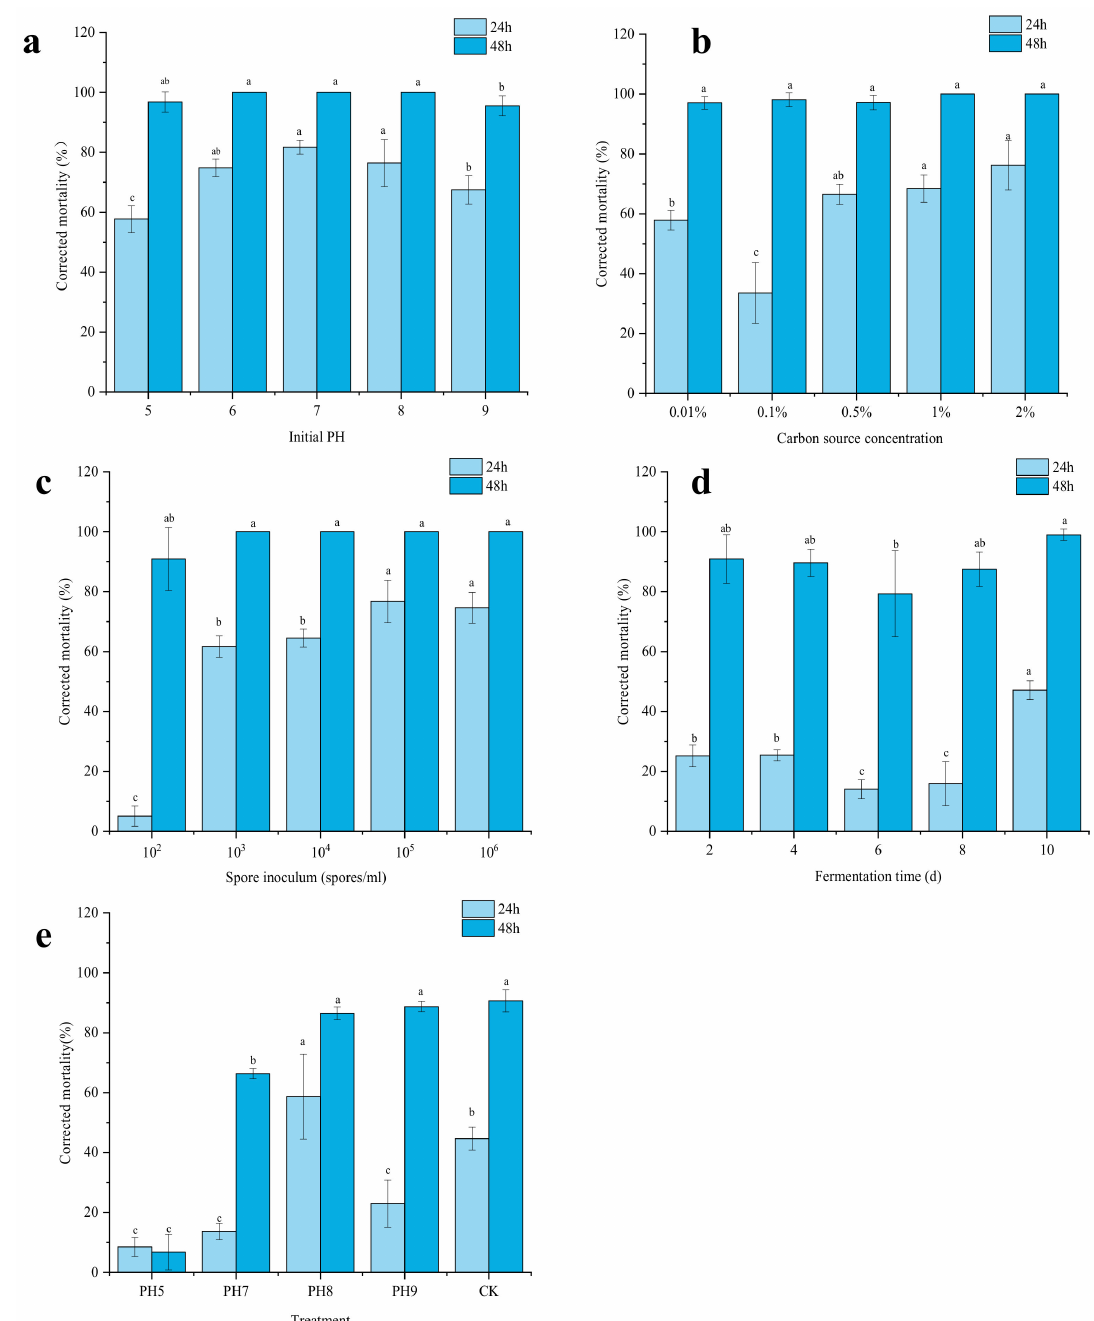
Figure 2. Effects of spore inoculum ( a ), initial pH ( b ), concentration ( c ), fermentation time ( d ), and pH after fermentation ( e ) on the nematicidal activity of culture filtrate of Purpureocillium lilacinum combined with 6-oxychitin (OTC-PLF) against M. incognita J2s. Different letters represent significant differences ( p < 0.05) according to Duncan’s